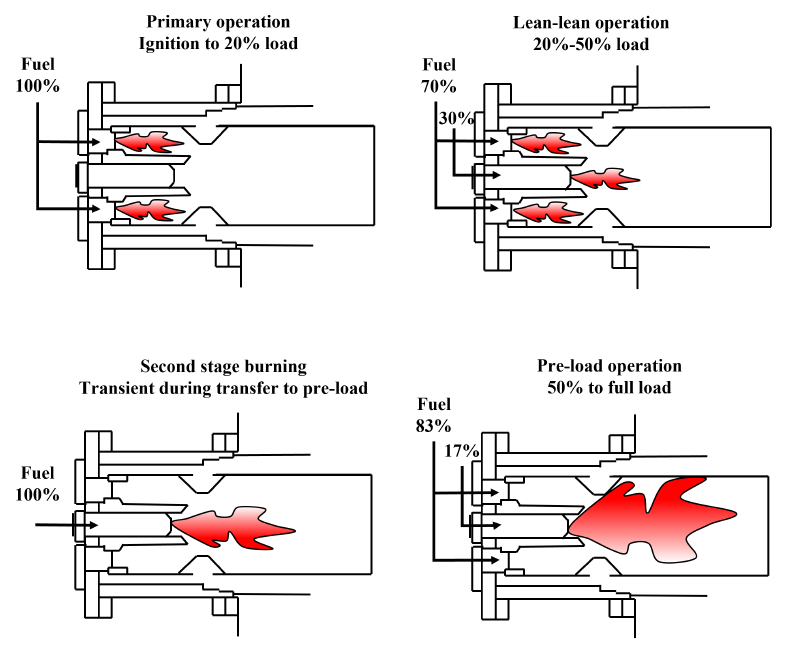
Figure 17. DLN-1